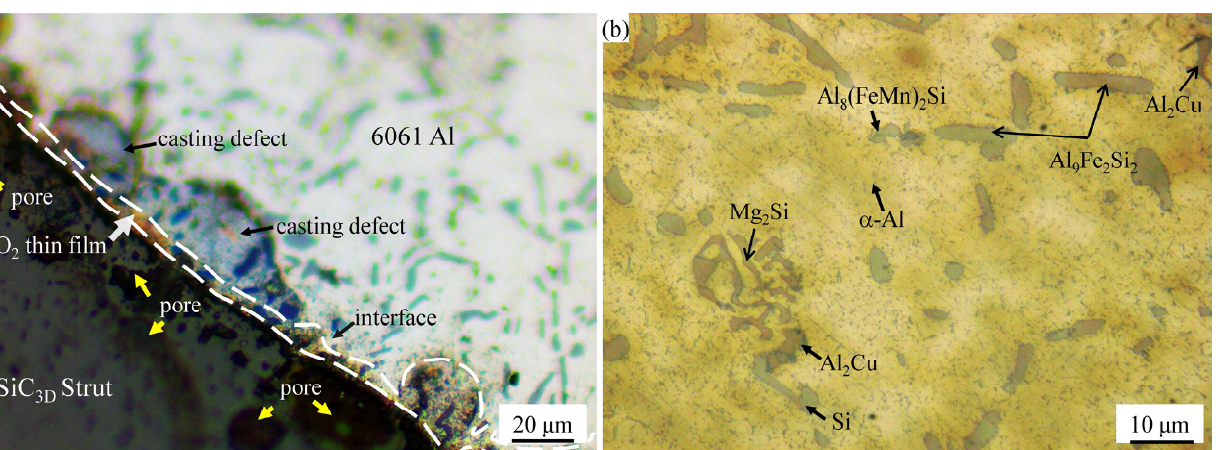
3D /6061Al; ( b ) 6061Al alloy.